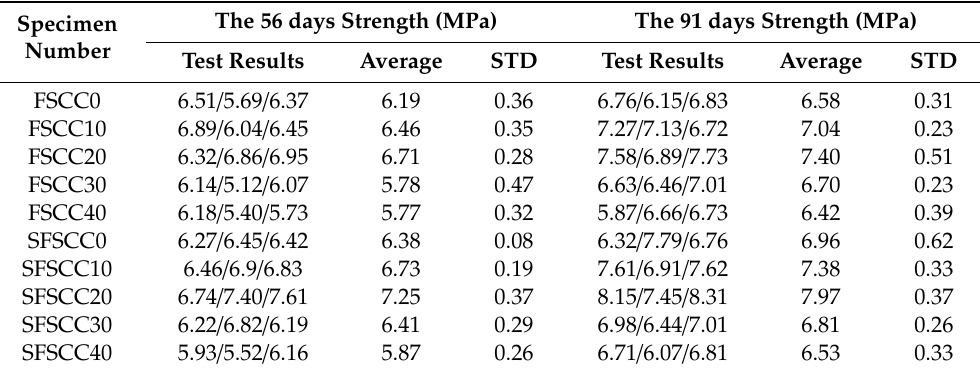
Table 7. Test results of 56 days and 91 days splitting strength of